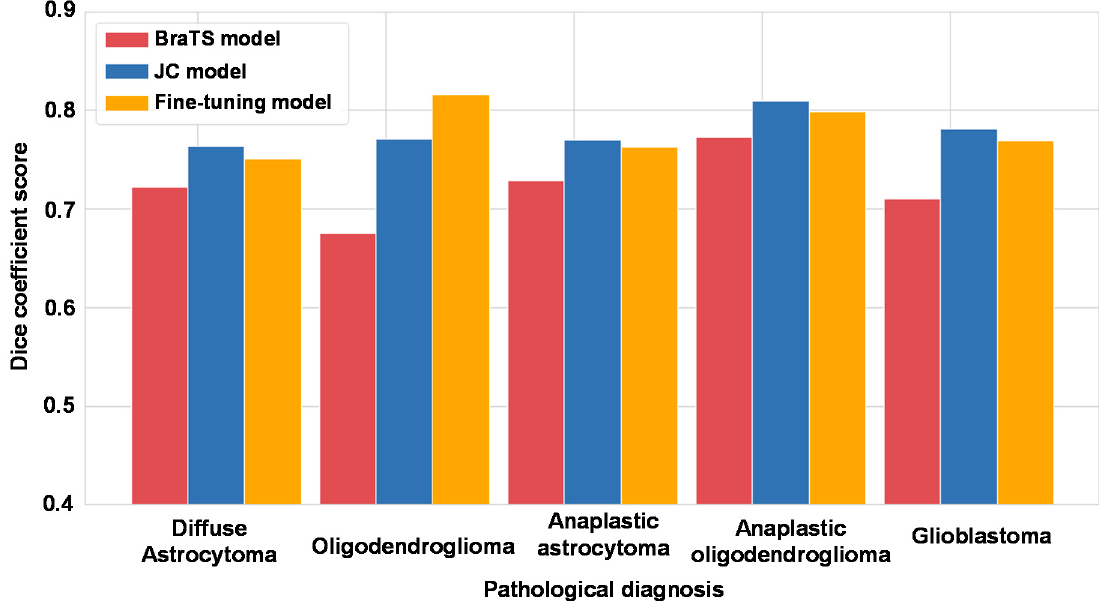
Figure 3. The results of three types of machine learning models for segmentation focused on pathological diagnosis. A bar graph shows the Dice coefficient score for each pathological diagnosis. The horizontal axis shows the pathological diagnosis, the vertical axis shows the Dice coefficient score, and the colors show the type of machine learning models for segmentation.